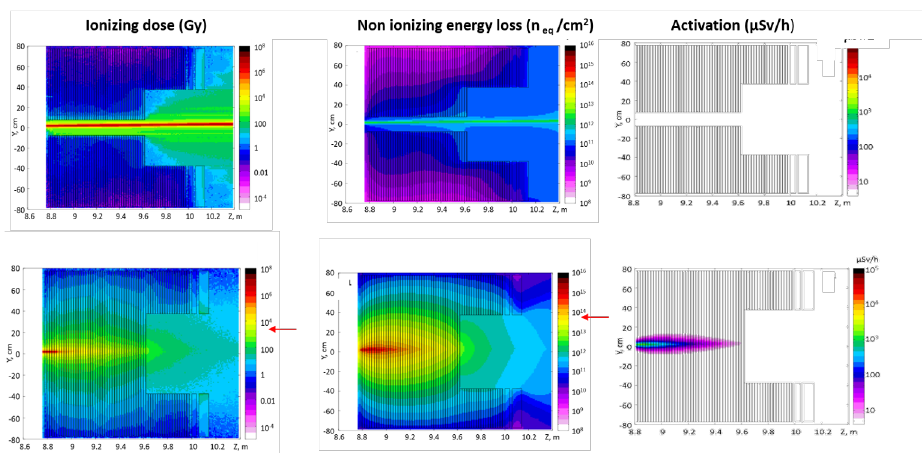
Figure 5. Results of FLUKA simulations of radiation doses from ionizing and non-ionizing particles and activation in the FHCal with a beam hole (upper row) and in the present ZDC (bottom row)